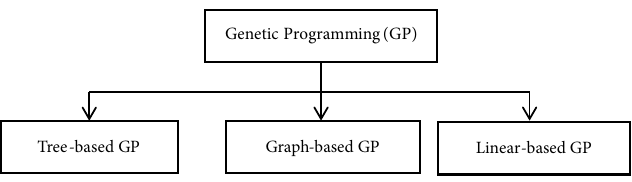
Fig. 1. Different types of GP